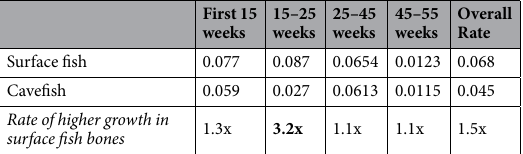
Table 1. SO3 bone growth rate (mm 2 /week) in surface and